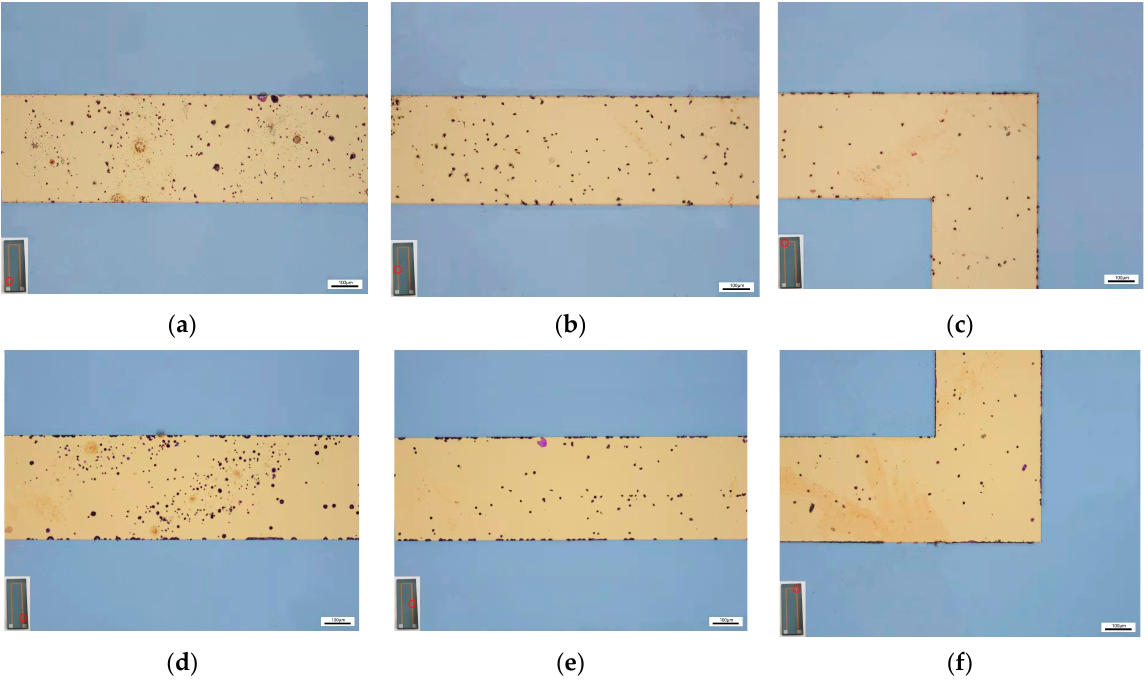
Figure 8. Optical images of the TFTC line. ( a ) The bottom of the TFTC left line; ( b ) The middle of the TFTC left line; ( c ) The top of the TFTC left line; ( d ) The bottom of the TFTC right line; ( e ) The middle of the TFTC right line; ( f ) The top of the TFTC right line.